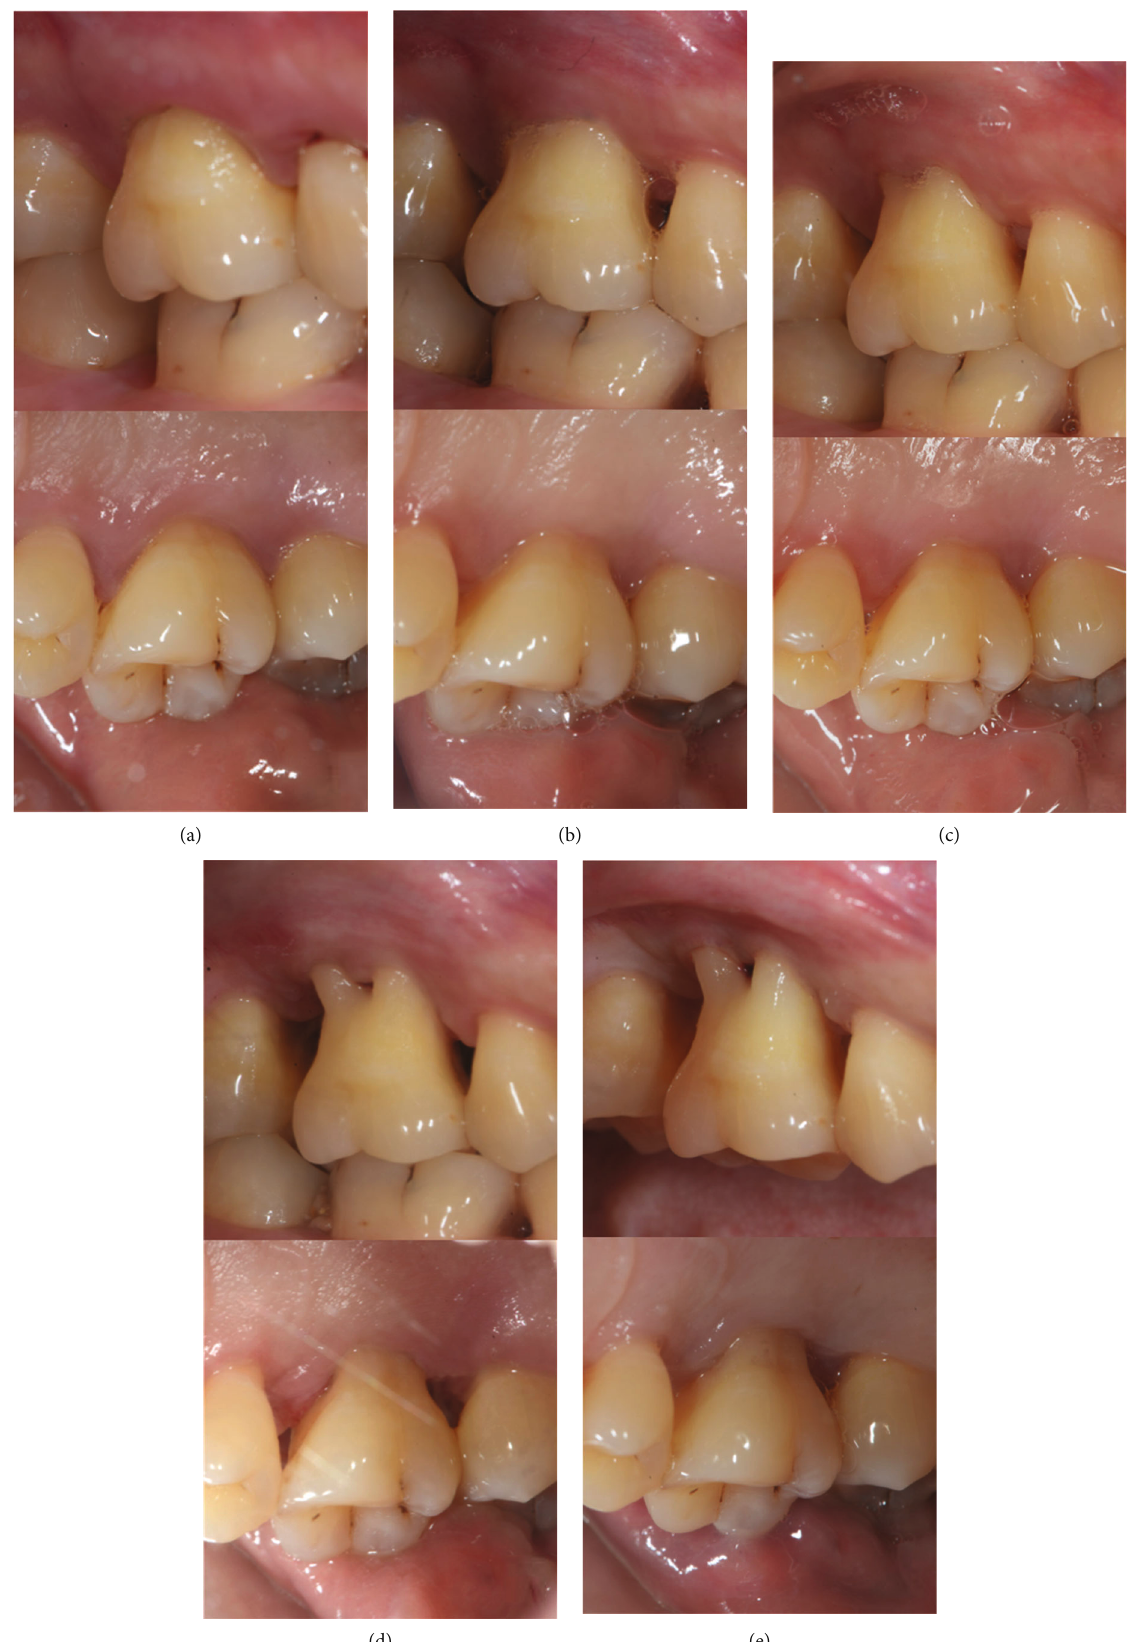
Figure 2: Tooth #16 acquired periodontally healthy status after active periodontal treatment. (a) Before periodontal treatment. (b) After 3 months of initial periodontal treatment (IPT) and supportive periodontal treatment (SPT). (c) After 5 months of IPT and SPT. (d) After 7 months of IPT and SPT. (e) After 10 months of IPT and SPT, a remittent status was acquired before the